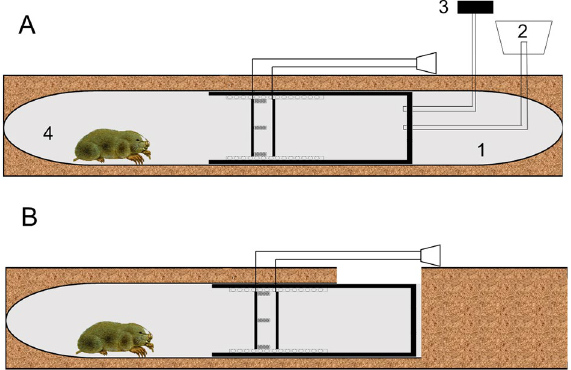
Figure 4. ( A ) Schematic drawing of the apparatus used in the oxygen treatment placed in the tunnel of the plateau zokor. ( B ) Schematic drawing of the apparatus used for the temperature and light treatments placed in the tunnel of the plateau zokor. (1) tunnel of the plateau zokor; (2) oxygen cylinder; (3) three-parameter soil gas analyzer; (4) plateau